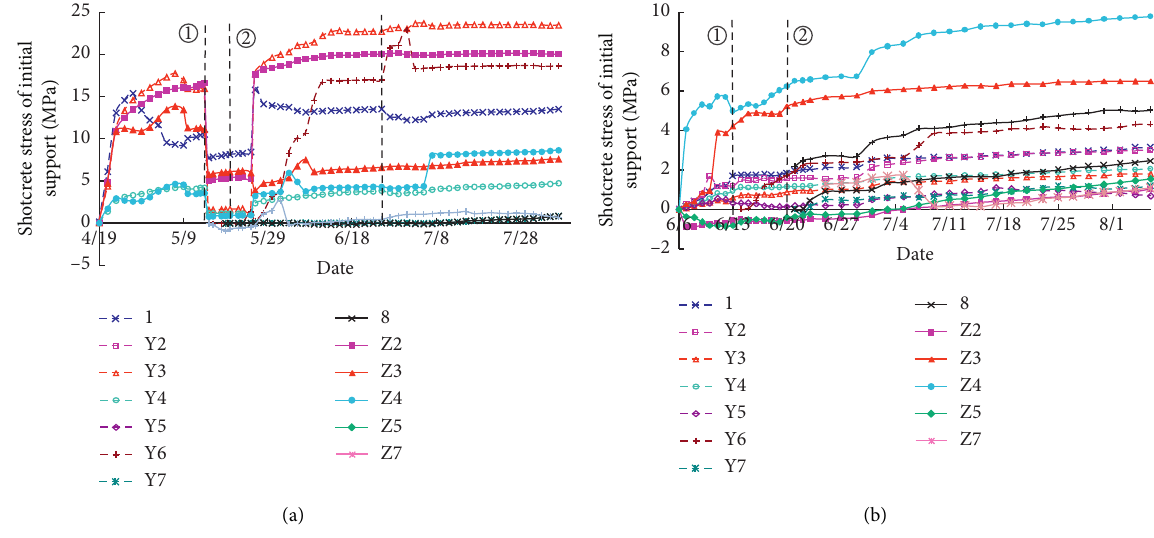
Figure 16: Time-history curves of shotcrete stress of initial support. (a) Section A. (b) Section